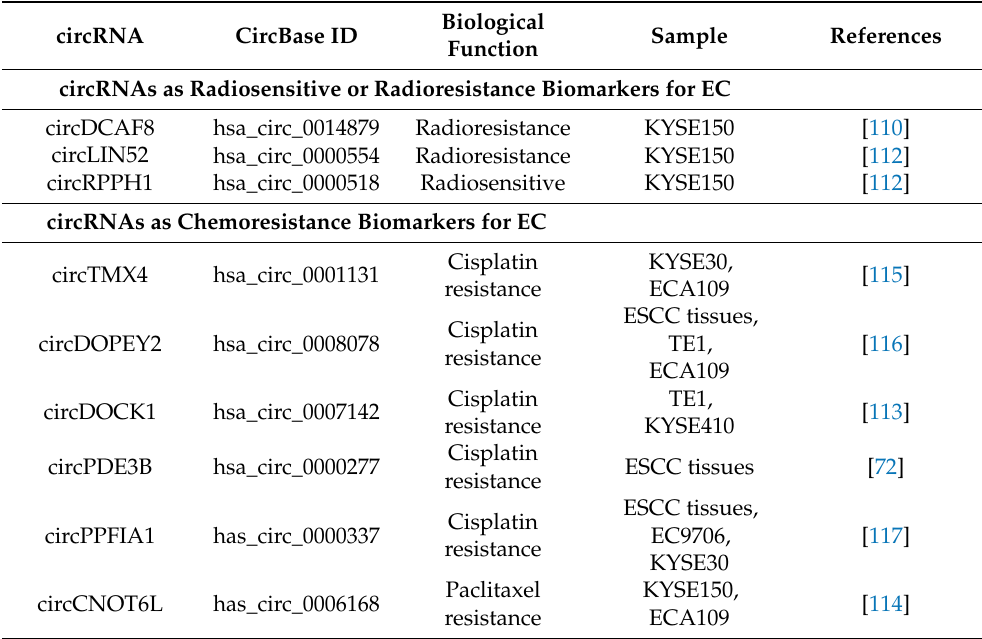
Table 2. circRNAs as biomarker for radio- and chemo-sensitivity in